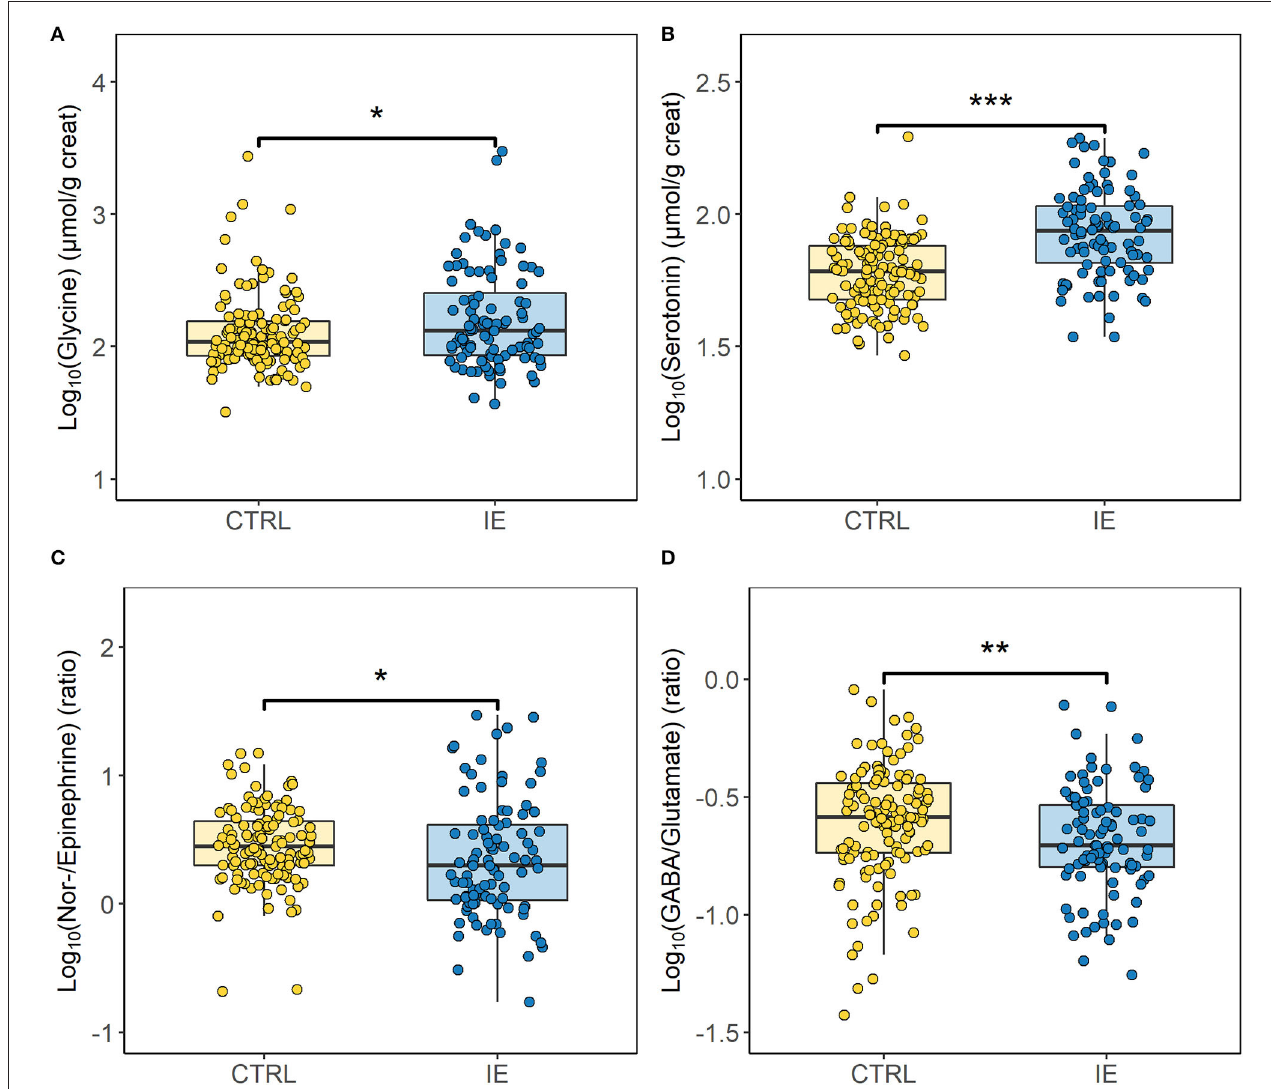
FIGURE 1 | Differences in the urinary neurotransmitter profile between dogs with idiopathic epilepsy (IE) ( n = 63 dogs/96 samples) and the healthy control group (CTRL) ( n = 127 dogs/127 samples). Figure shows an increase of urinary (A) glycine ( p ≤ 0.05) and (B) serotonin ( p ≤ 0.001) concentrations and a decrease of the (C) norepinephrine/epinephrine ratio ( p ≤ 0.05) and the (D) È -aminobutyric acid (GABA)/glutamate ratio ( p ≤ 0.01) in dogs affected by idiopathic epilepsy. Data are presented as box-and-whisker plots (the median is represented by the central line, the 25th and the 75th percentile represent the lower and upper limit, and the length of the whiskers represent the 1.5 multiple of the interquartile range). Unpaired two-sided two-sample t -test and Wilcoxon–Mann–Whitney test were used to compare the urinary neurotransmitter excretion between dogs with epilepsy and the healthy control group. * p ≤ 0.05, ** p ≤ 0.01 and *** p ≤